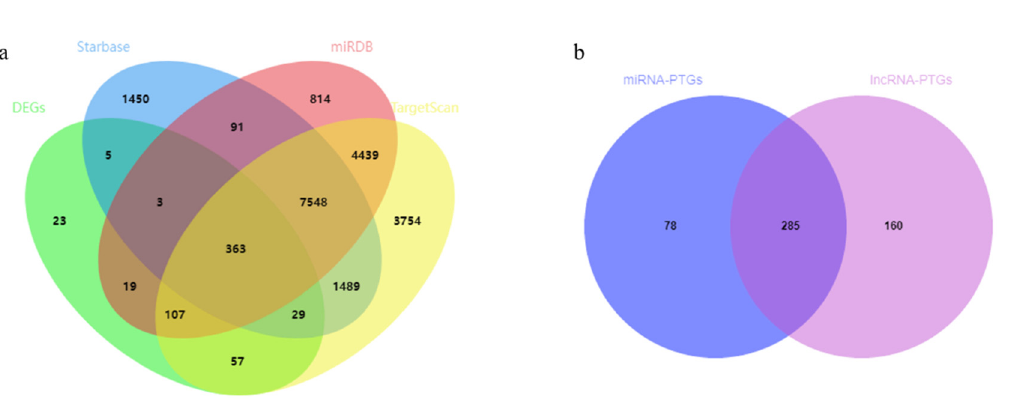
Figure 3. Functional enrichment analysis of differentially expressed genes (DEGs). ( a ) GO annota- tion of DEGs; ( b ) KEGG pathway analysis of DEGs.